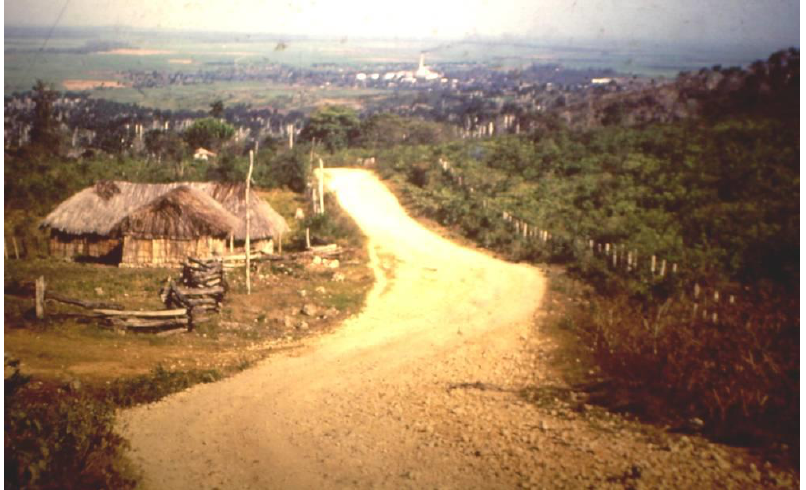
Figure 4. The Báguanos Valley . 47 Figure 4. The B á guanos Valley.